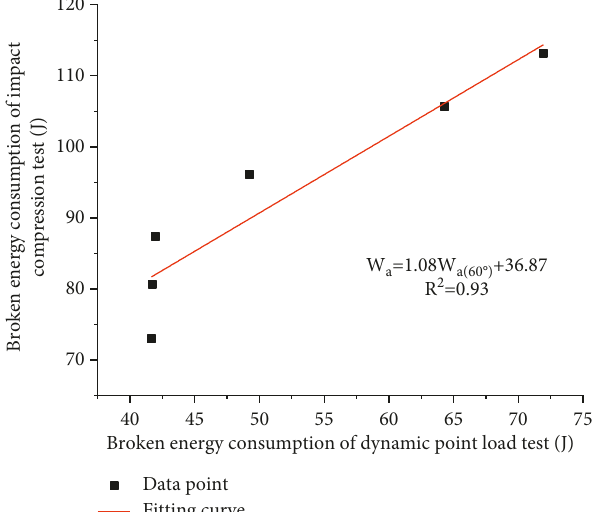
Figure 13: Fitting curve of crushing energy consumption of impact compression test-crushing energy consumption of dynamic point load test at conical angle of 60 °